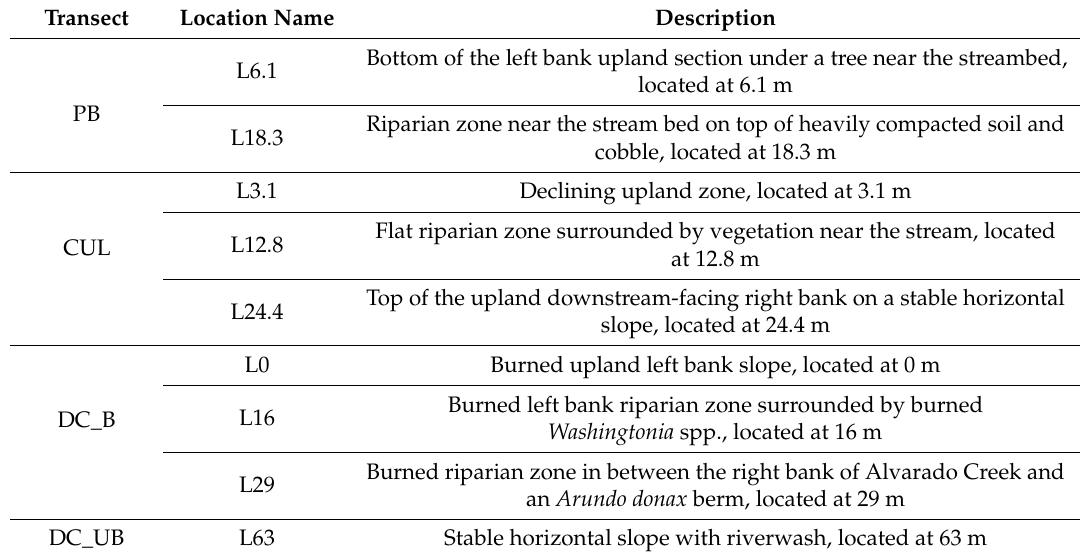
Table 1. Description of infiltration locations for the unburned pedestrian bridge (PB), unburned culvert (CUL), burned Del Cerro (DC), and unburned (DC_UB) sites. The names are defined as the sampling position along the transect, which is located a specific distance in meters from the start of the